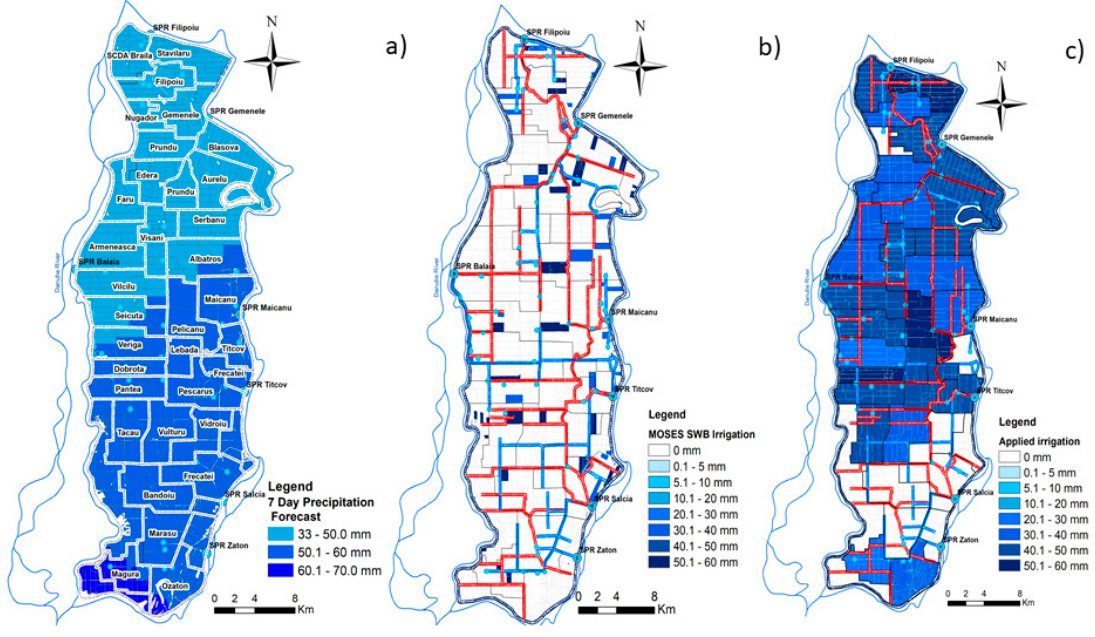
Figure 10. Precipitation forecast ( a ), irrigation forecast ( b ), and applied irrigation ( c ), 22–28 June 2018.